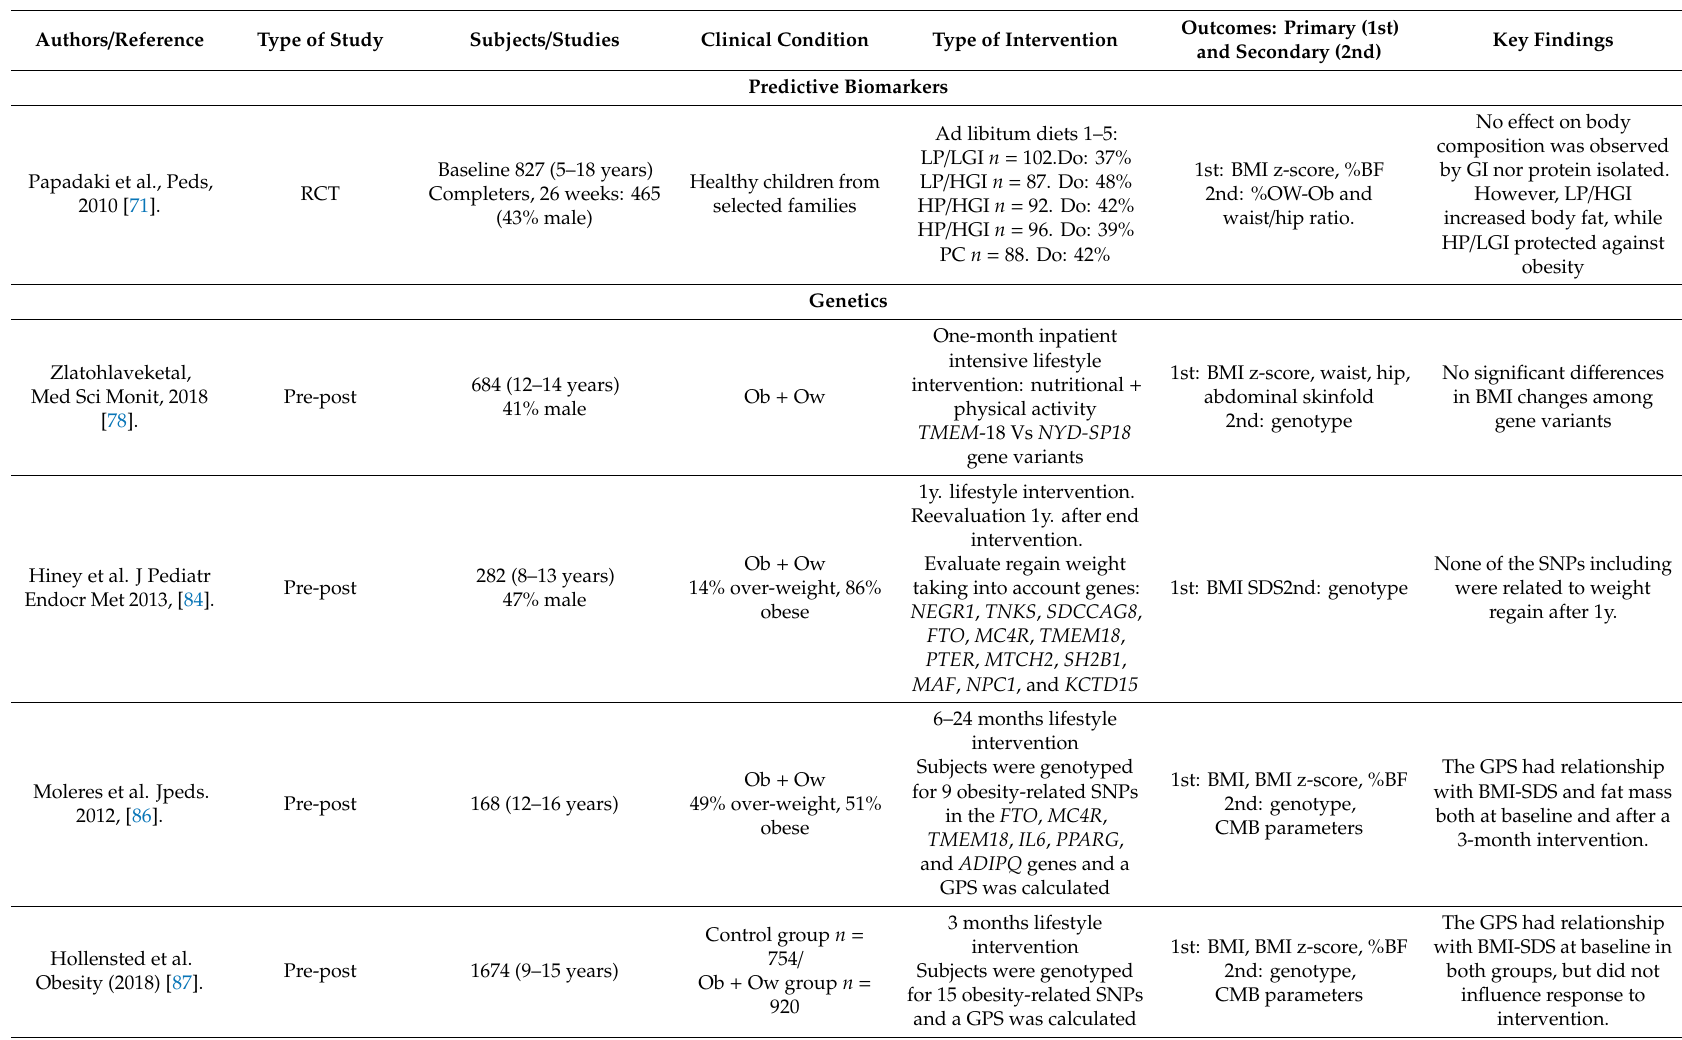
Table 3. Summary of pediatric biological level interventions included in the